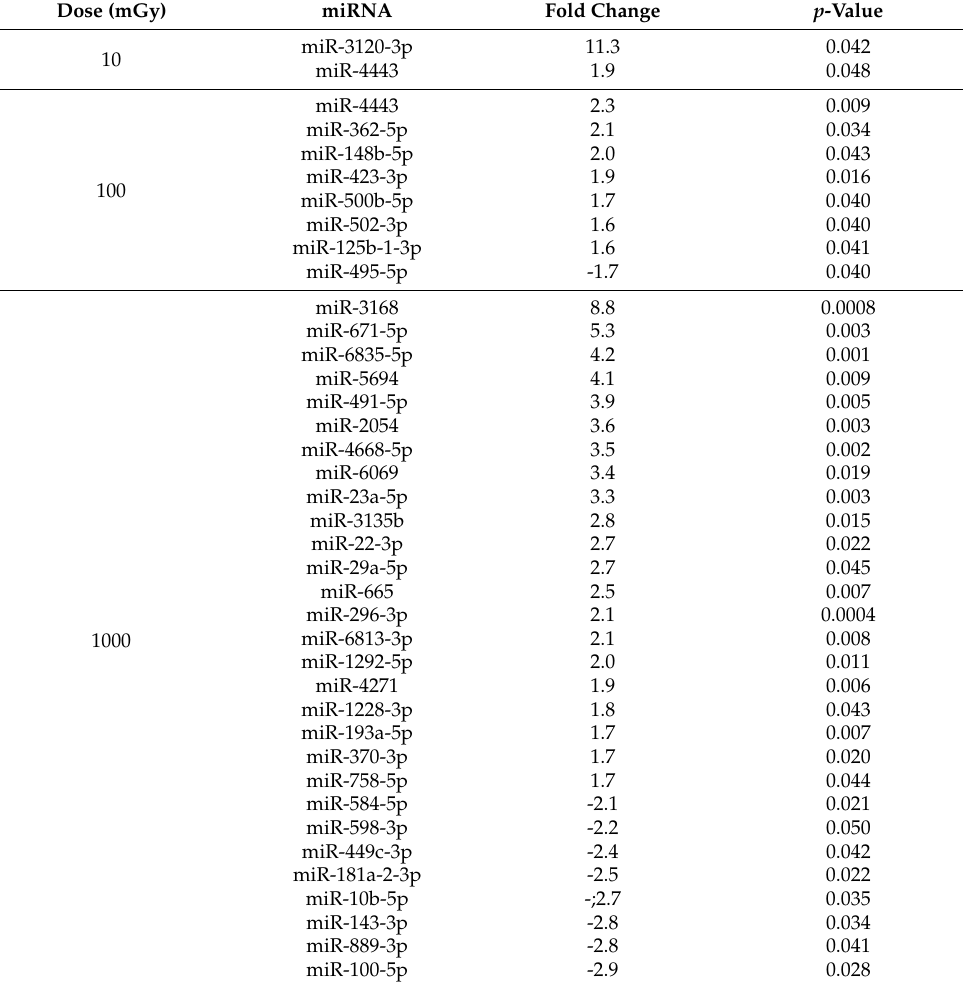
Table 1. Dysregulated miRNA in CGL1 cells 6 h post-irradiation. Dose (mGy) miRNA Fold Change p